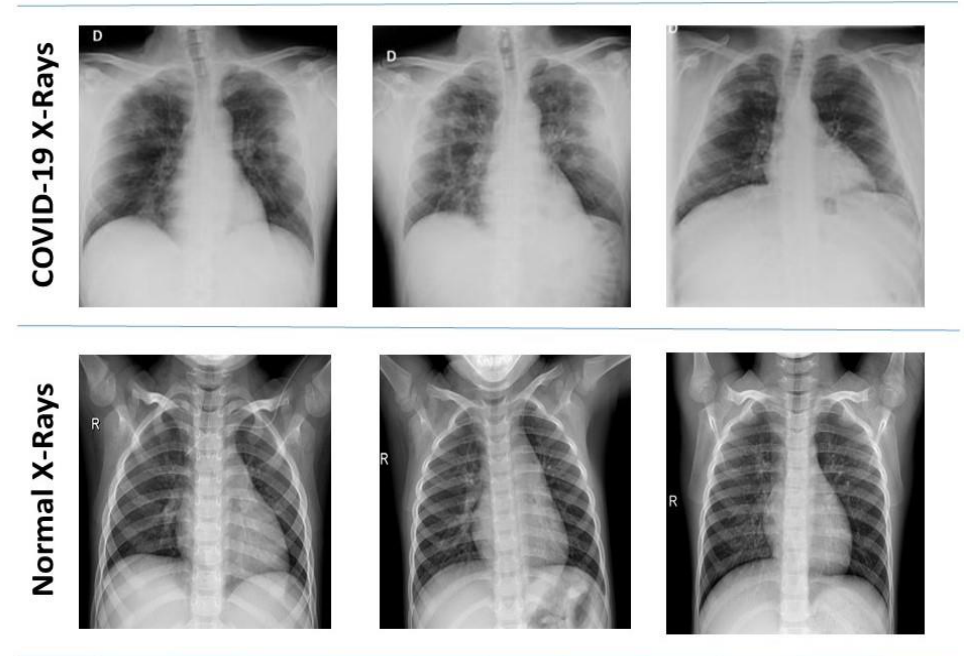
Figure 2. COVID-19 and normal X-rays sample from the dataset.